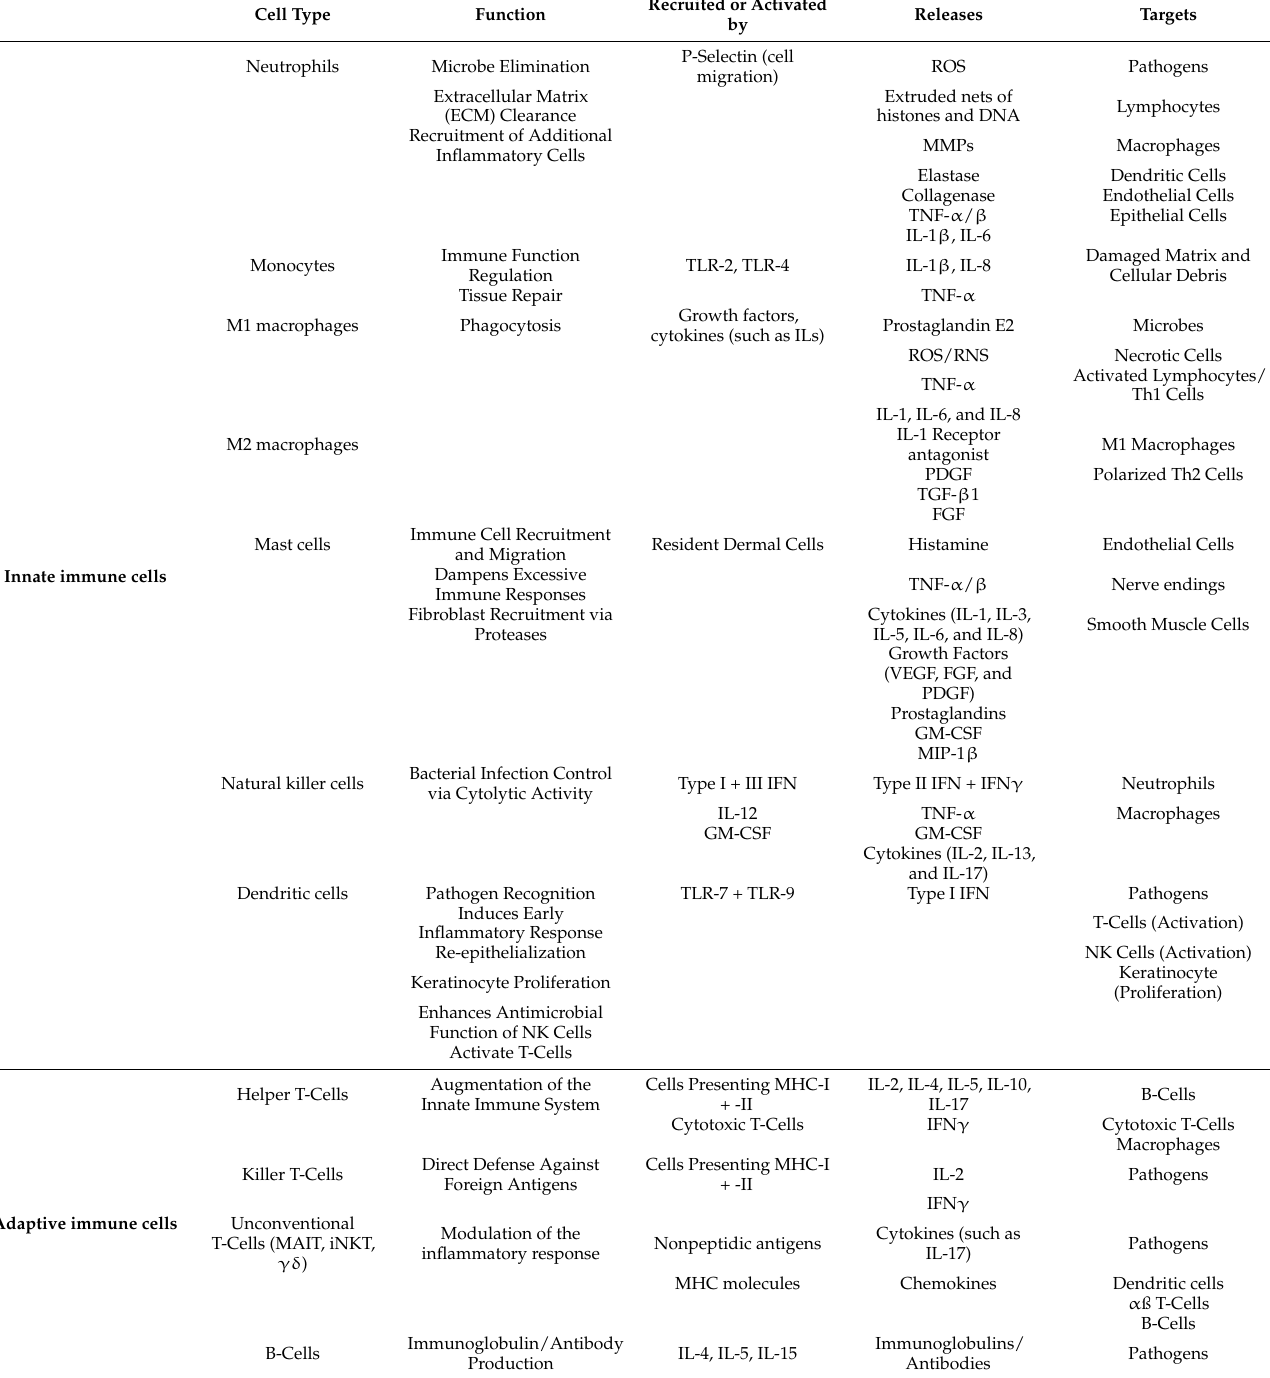
Table 1. Immune and regenerative cells and their roles and characteristics during burn injury. Abbreviations: GM-CSF, granulocyte-macrophage colony stimulating factor; EGF, epidermal growth factor; FGF, fibroblast growth factor; IFN, interferon; IL, interleukin; KGF, keratinocyte growth factor; MHC, major histocompatibility complex; MMP, matrix metalloproteinase; MSH,